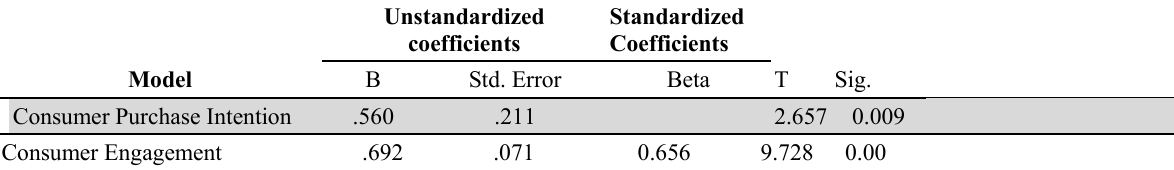
Regression Analysis of Consumer Engagement on Consumer Purchasing Intention Unstandardized Standardized coefficients Coefficients Model Consumer Purchase Intention .560 .211 Consumer Engagement .692